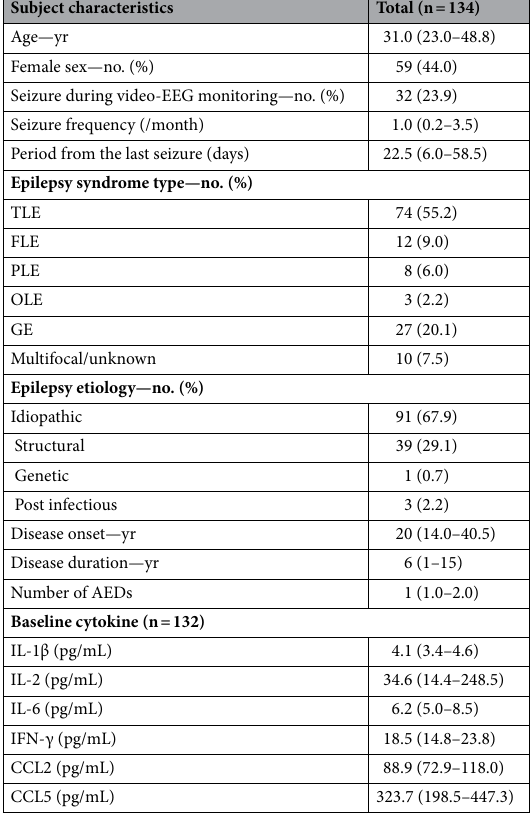
Table 1. Clinical characteristics of study patients. TLE: temporal lobe epilepsy; FLE: frontal lobe epilepsy; PLE: parietal lobe epilepsy; OLE: occipital lobe epilepsy; GE: generalized epilepsy; AED: antiepileptic drugs; IL: interleukin; IFN-γ: interferon-gamma; CCL: chemokine motif ligand. Data are reported as the number (percentage), or as the median (interquartile range,